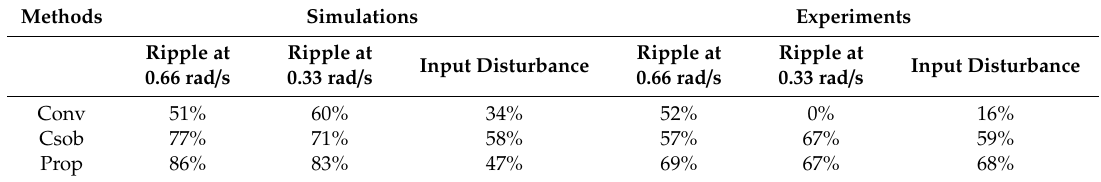
Table 9. Suppression percentage of Conv, Csob, and Prop methods compared to PI method with link-side